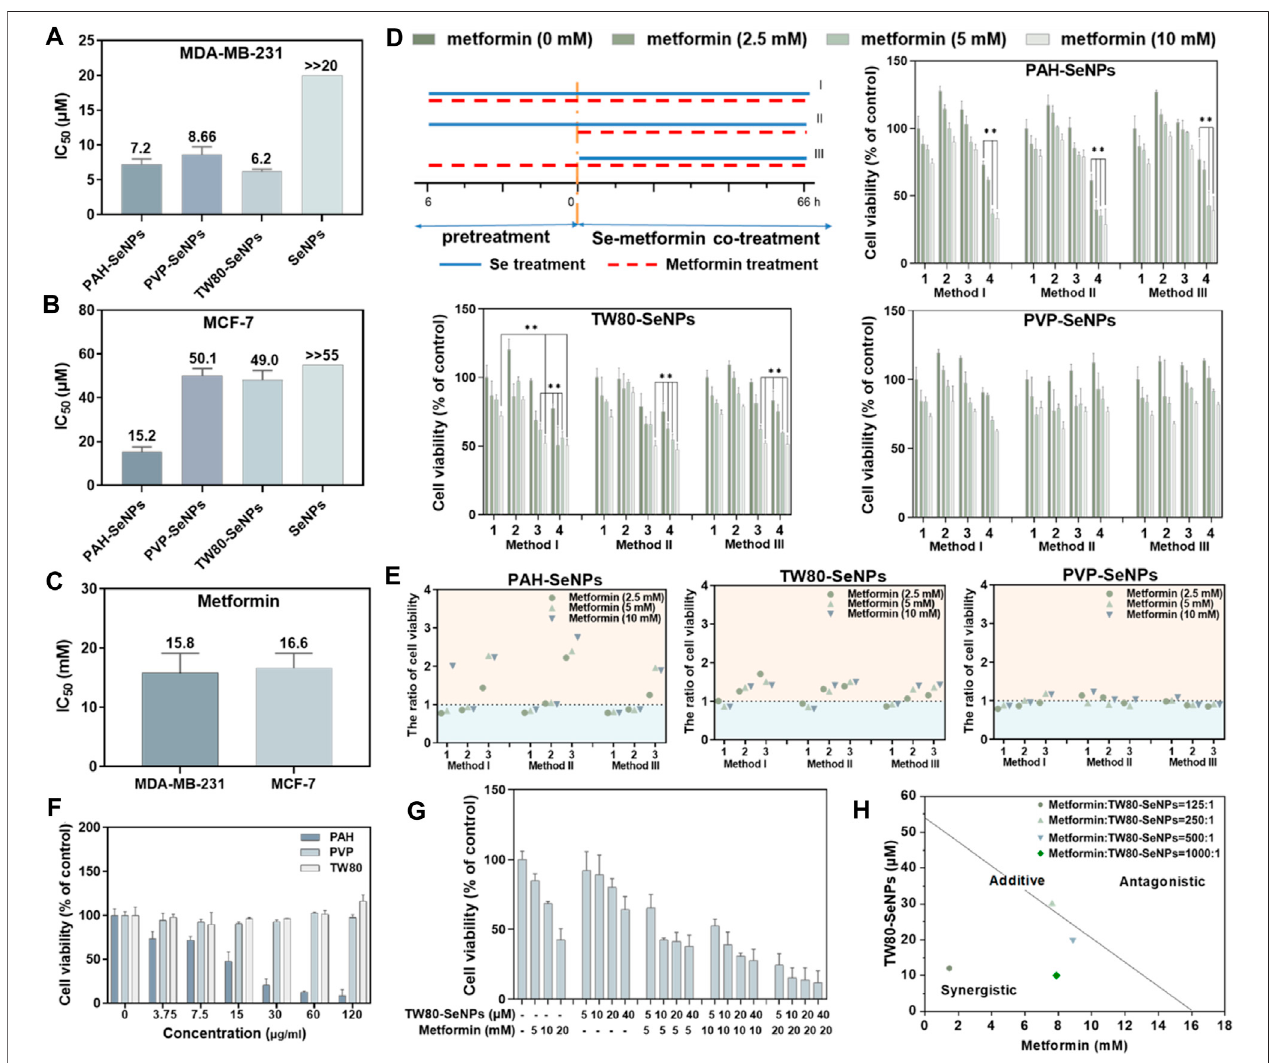
FIGURE 2 | IC 50 values of functionalized SeNPs to MDA-MB-231 (A) and MCF-7 (B) cells. (C) IC 50 values of metformin to MDA-MB-231 and MCF-7 cells. (D) Effects on MCF-7 cell viability of different functionalized SeNPs combined with metformin under three treatment methods, where 1, 2, 3, and four represent Se concentrations of 0, 5, 10 and 20 μ M, respectively. * p < 0.05, ** p < 0.01, with signi fi cant statistical difference. (E) Survival rates of cells with and without SeNPs and the same concentration of metformin. The horizontal coordinates 1, 2 and 3 represent Se concentrations of 5, 10 and 20 μ M, respectively. Points greater than one on the ordinate indicate some synergy. (F) Toxicity evaluation of PAH, TW80, and PVP with MCF-7 cells. (G) Evaluating the effects of TW80-SeNPs combined with metformin on MCF-7 cells. (H) Isobologram analysis of the antiproliferative effects of TW80-SeNPs and metformin on MCF-7 cells.